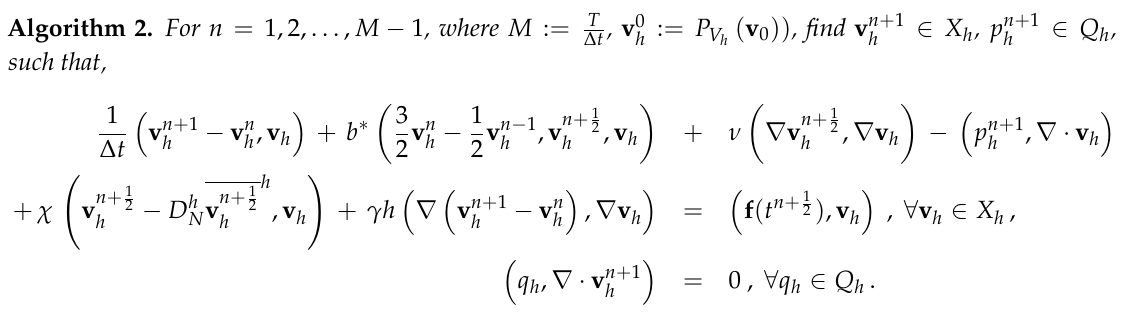
Algorithm 2. For n = 1, 2, . . . , M − 1 , where M : = T ∆